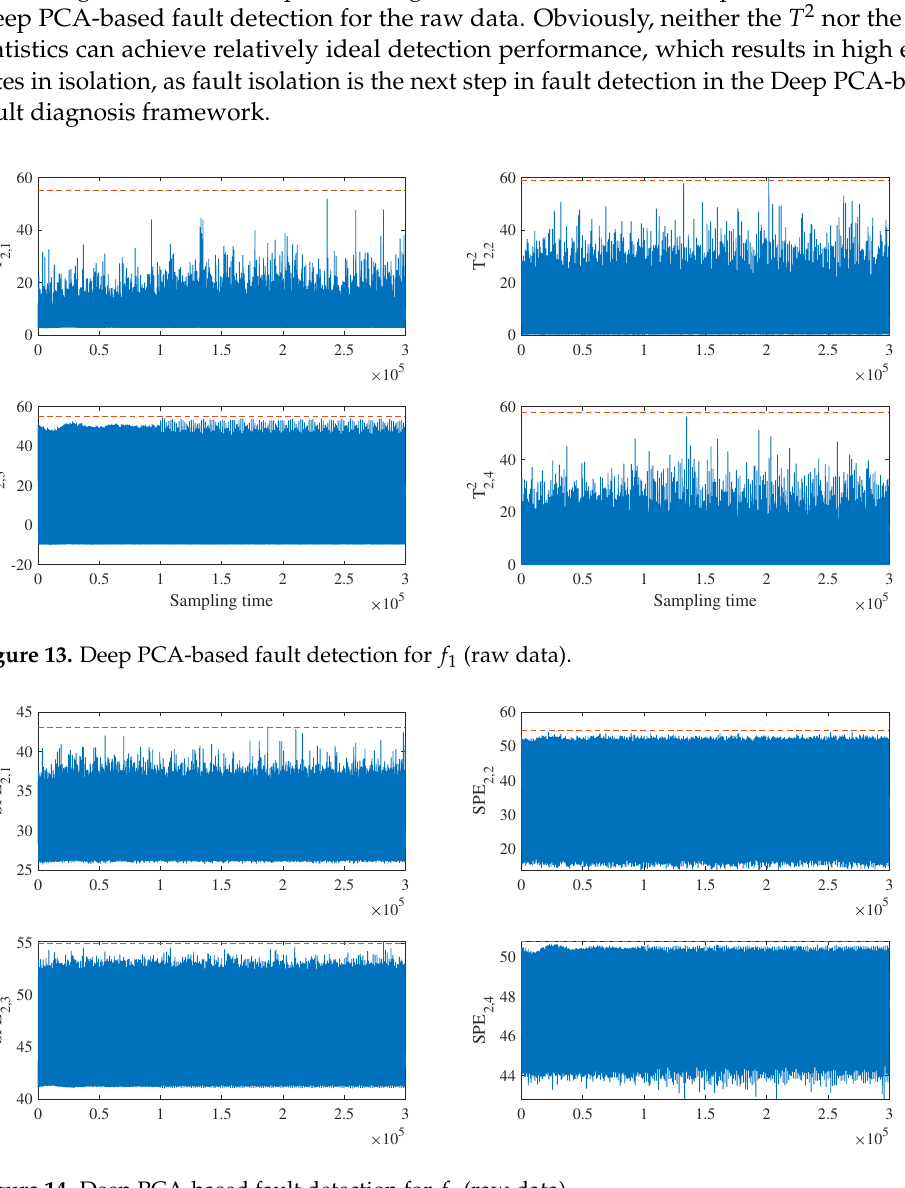
Figure 14. Deep PCA-based fault detection for f 1 (raw